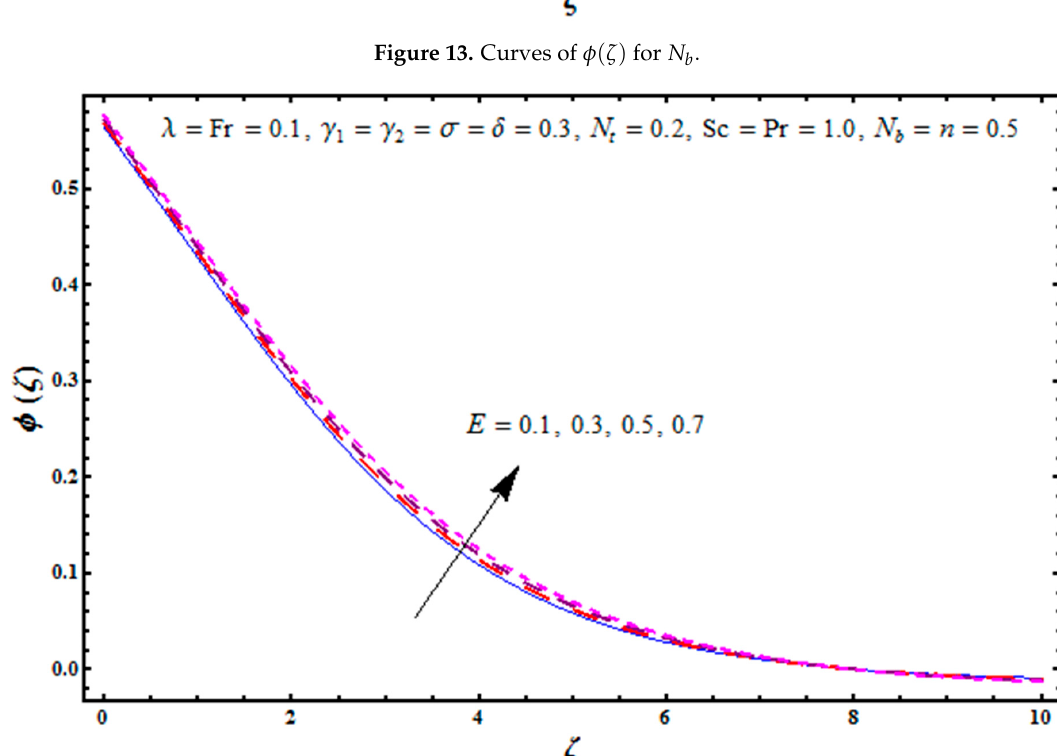
Figure 14. Curves of φ ( ζ ) for E